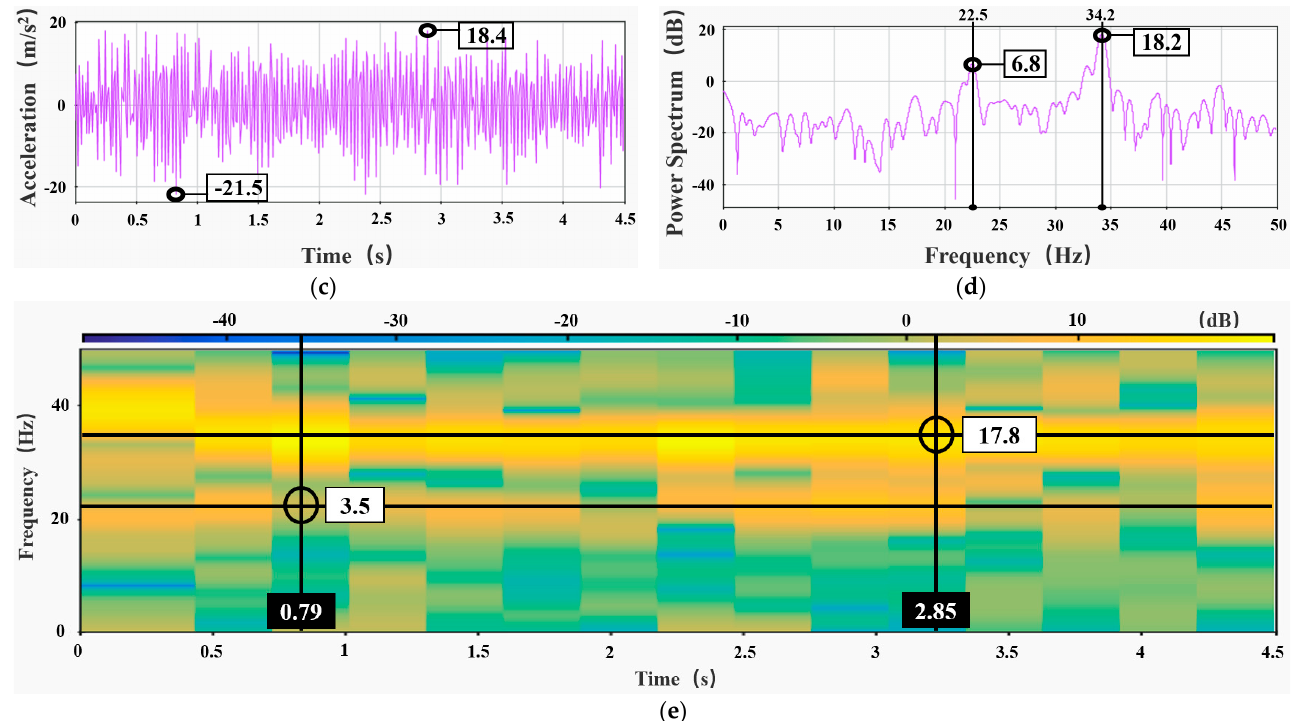
Figure 13. Static comminution test results of the tractor travel protection frame: ( a ) three-way time-frequency diagram; ( b ) three-way amplitude-frequency diagram; ( c ) time-frequency diagram in the x-direction; ( d ) amplitude-frequency diagram in the x-direction; ( e ) time-frequency domain diagram in the x-direction.